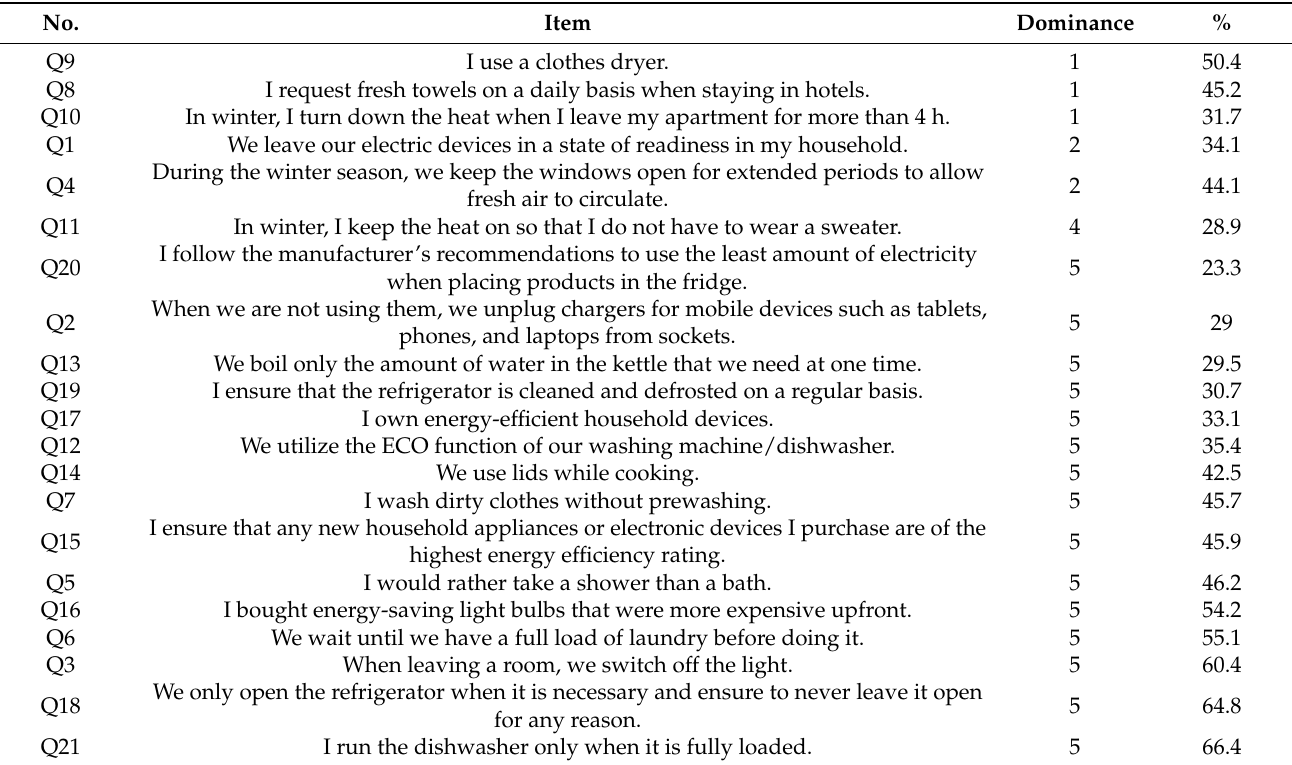
Figure 2. Energy behaviors of prosumers: distribution of responses in Table 2. Source: own research. Table 3. Prosumer energy behaviors according to the dominance of each question.